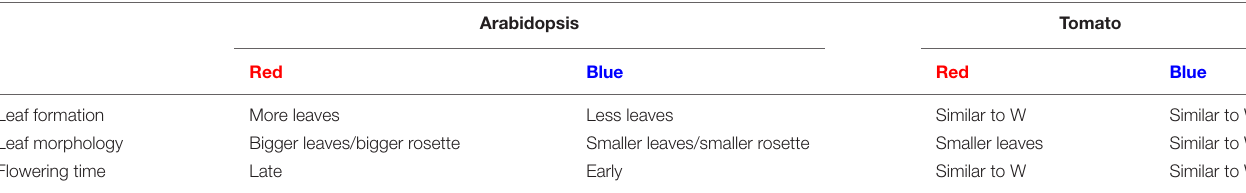
between LED conditions, it is indicated as “similar to white (W).” Asterisks indicate results that are ecotype-, or cultivar-dependent. Double Asterisks indicate results that are time-dependent. TABLE 2 | Developmental phase transitions are modulated by red and blue light in Arabidopsis, but not in tomato.